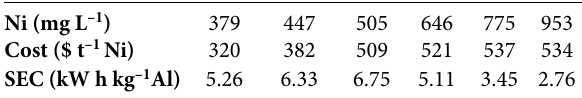
Table 8. Estimated operating costs for nickel removal by electroco- agulation Base: 98% removing, 9.8 mA cm –2 , 60 °C, pH